Question: Provide a publication-style caption for this figure.
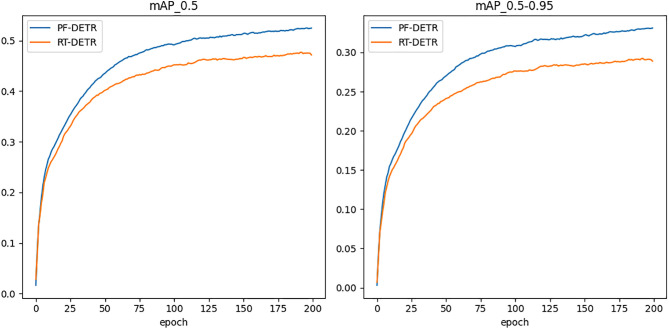
Answer: Comparison of Training Curves.